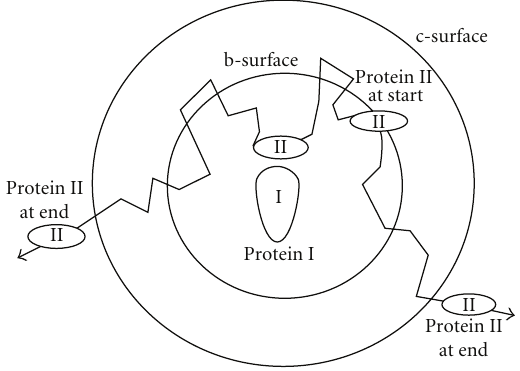
Figure 1: A schematic representation of the Brownian dynamics simulations of the association between two proteins. Simulations are conducted in coordinates defined relative to the position of the center of the protein, protein